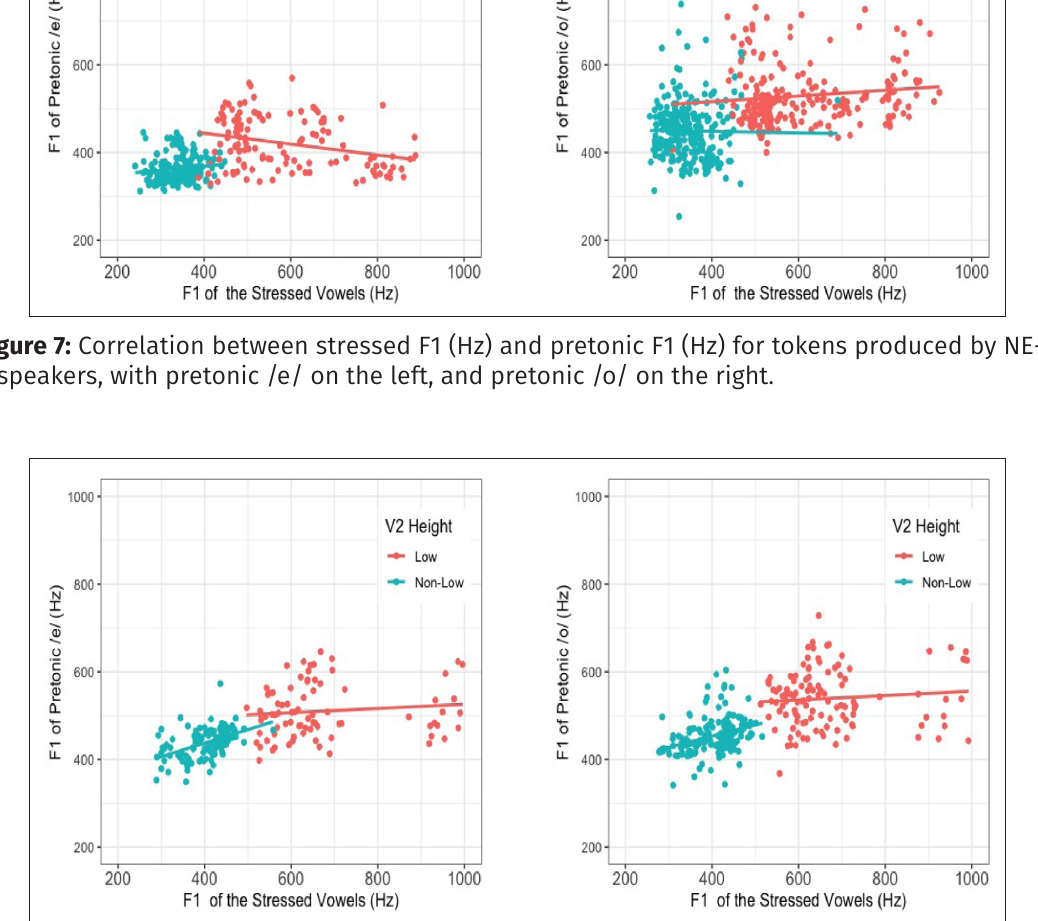
Figure 8: Correlation between stressed F1 (Hz) and pretonic F1 (Hz) for tokens produced by N-D speakers, with pretonic /e/ on the left, and pretonic /o/ on the